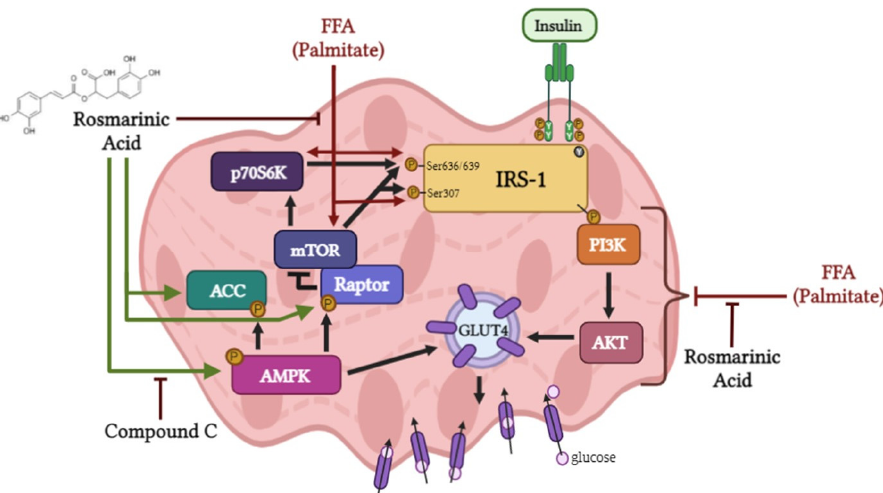
Figure 8. Rosmarinic acid counteracted the free fatty acid (FFA; palmitate)-induced muscle cell insulin resistance. Rosmarinic acid (RA) prevented the palmitate-induced phosphorylation/activation of mTOR and p70S6K, and increased the phosphorylation/activation of AMPK, ACC, and Raptor. RA restored insulin-stimulated Akt phosphorylation/activation, GLUT4 translocation, and glucose uptake in the presence of palmitate. Compound C (CC) prevented the effects of RA on the palmitate-induced phosphorylation/activation of mTOR and p70S6K and reduced the phosphorylation/activation of Raptor.